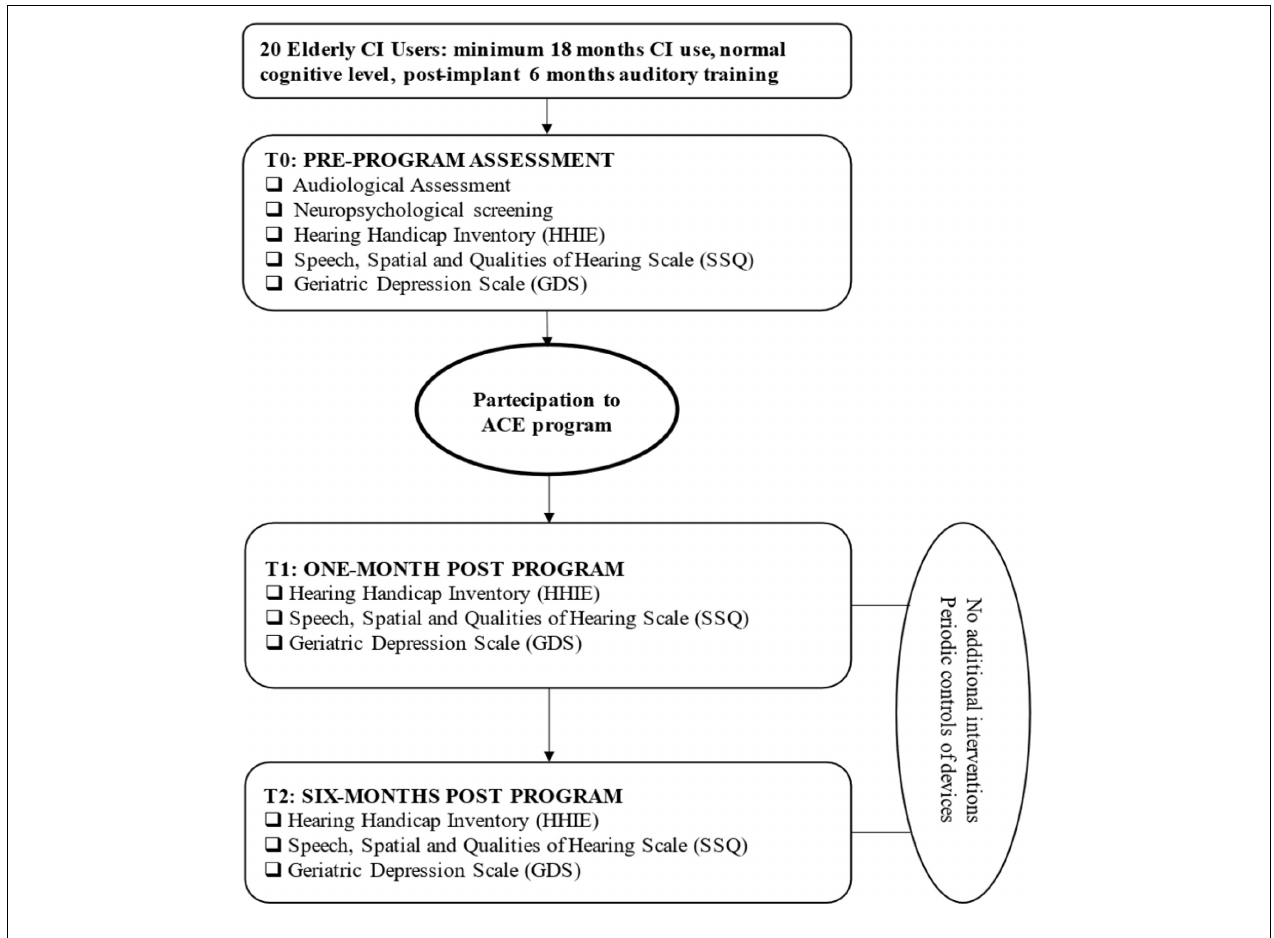
FIGURE 1 | Flowchart of patient assessment during the ACE